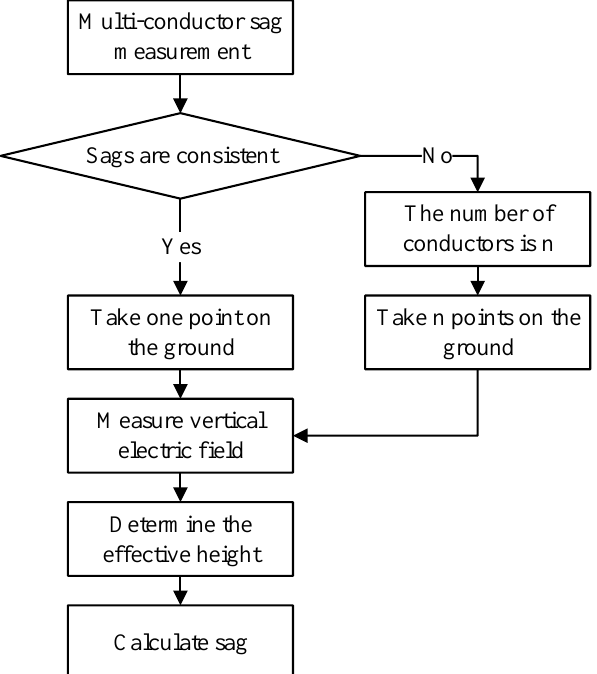
Figure 25. Multi-conductor sag measurement process.